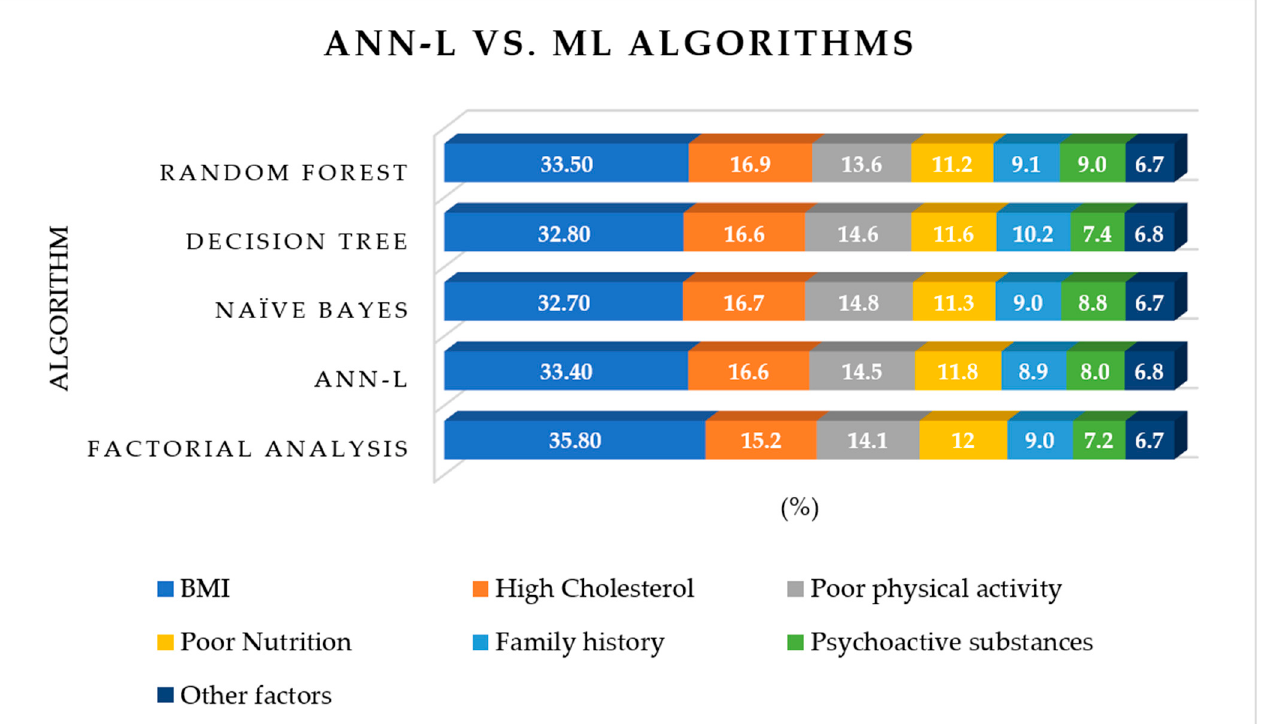
Figure 5. Graphical representation—the percentage share of each risk factor for the occurrence of hyperinsulinemia for the used models.